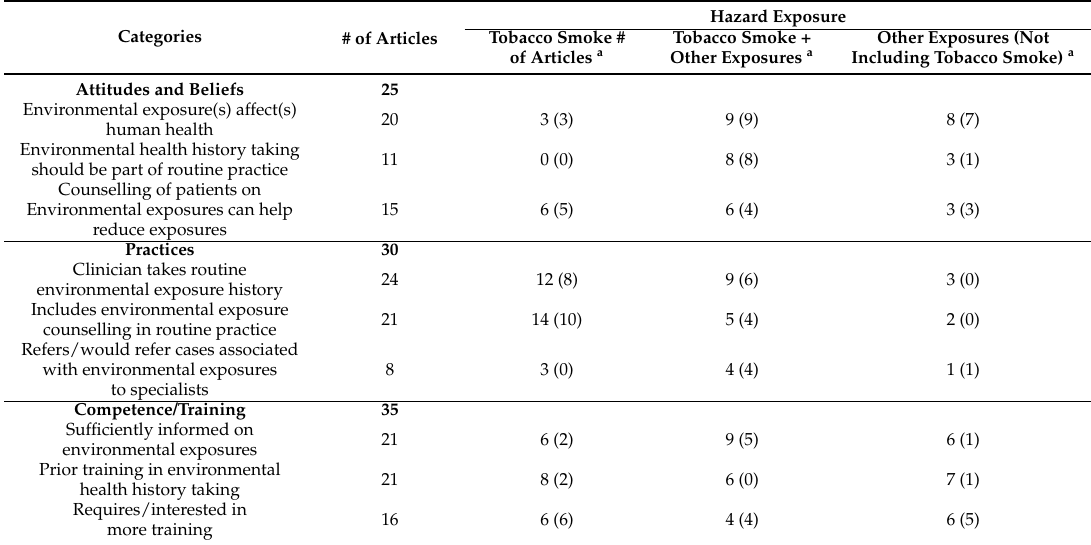
Table 3. Number of articles assessing hazard(s) and clinician responses to questionnaire